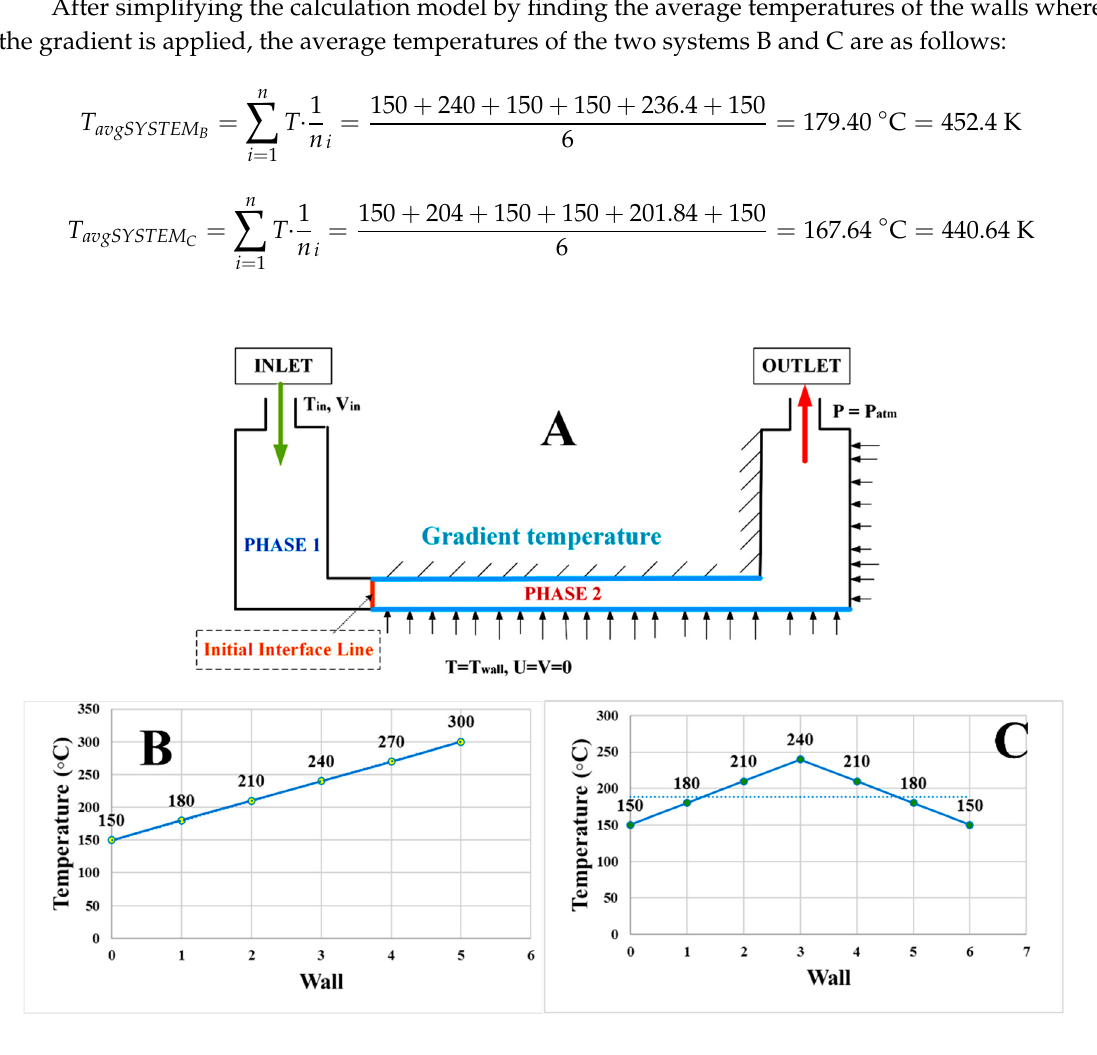
Figure 9. Variation of the temperature along the walls in blue that have been divided into equal segments. ( A ) new boundary conditions, ( B ) increasing temperature, ( C ) increasing and decreasing